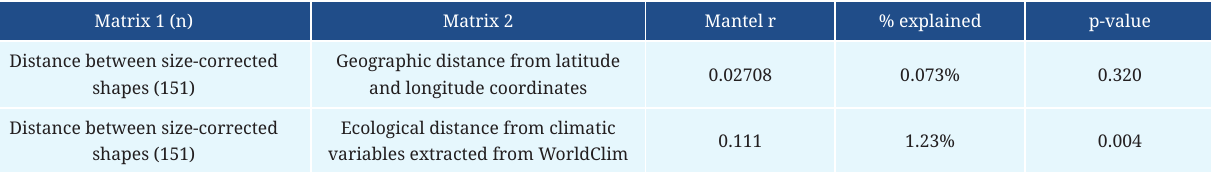
TABLE 3 | Mantel correlation Matrix 1 (n) Matrix 2 Mantel r % explained p-value Distance between size-corrected Geographic distance from latitude shapes (151) and longitude coordinates Distance between size-corrected Ecological distance from climatic shapes (151) variables extracted from WorldClim